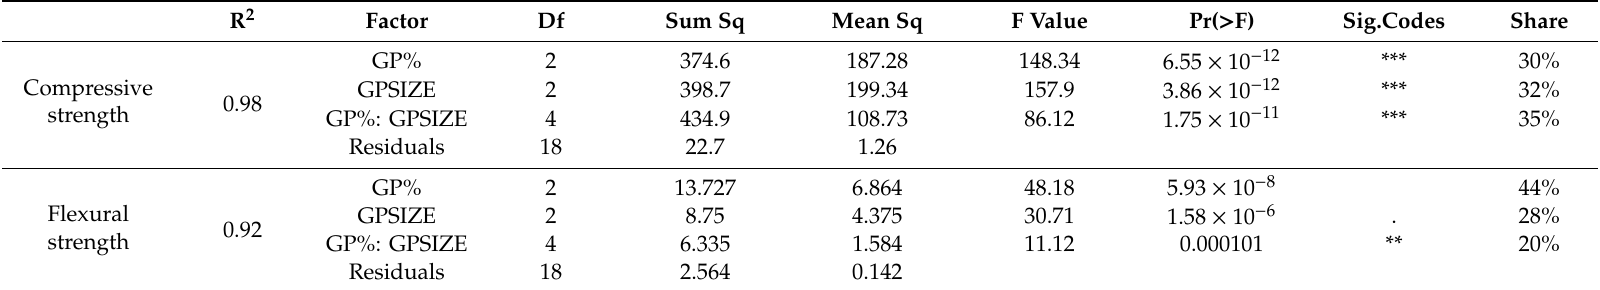
Table 6. Analysis of Variance results for 90 days of